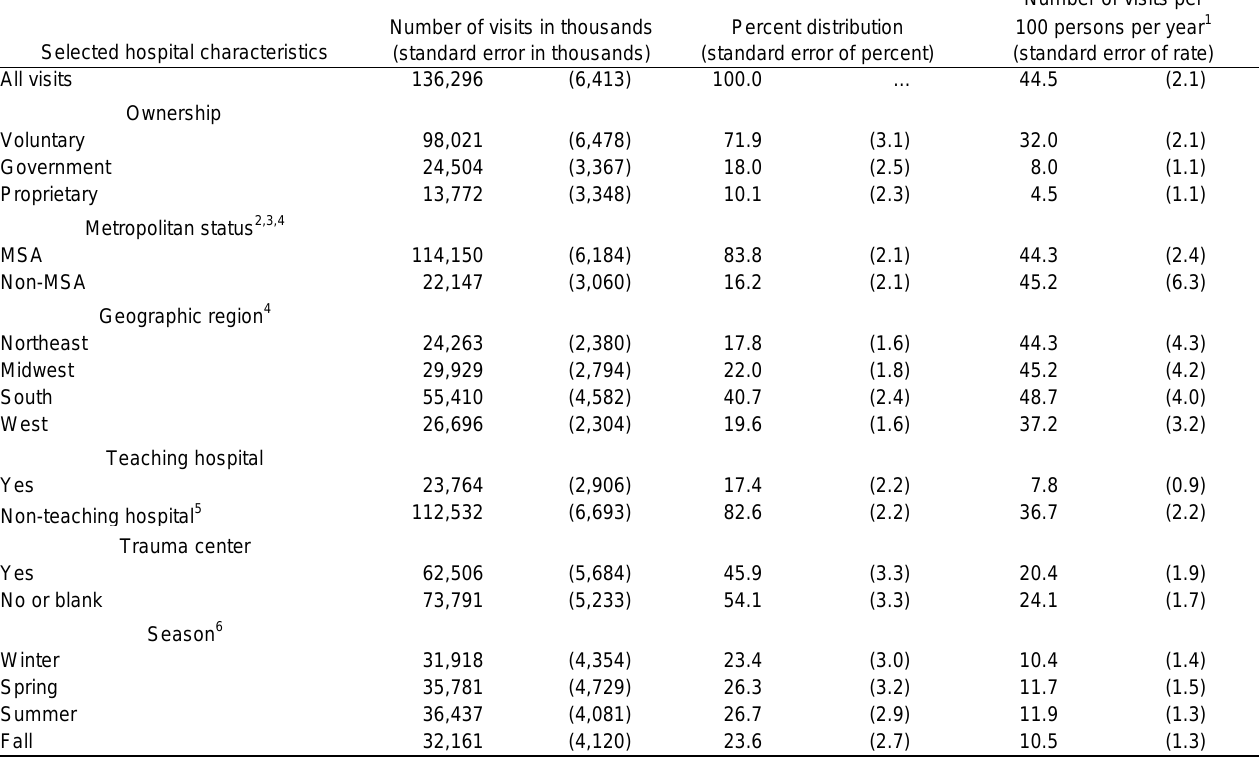
Table 1. Emergency department visits by selected hospital characteristics: United States,